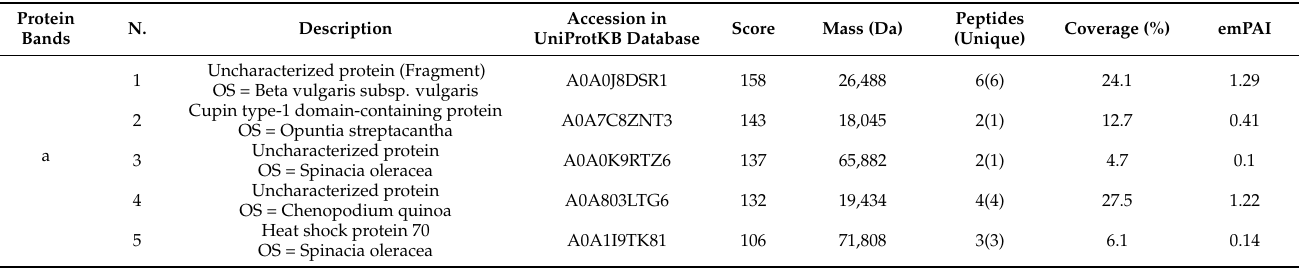
Table 1. Top 10% of proteins identified by LC–MS/MS in excised gel spots from white-fleshed pitaya seeds.